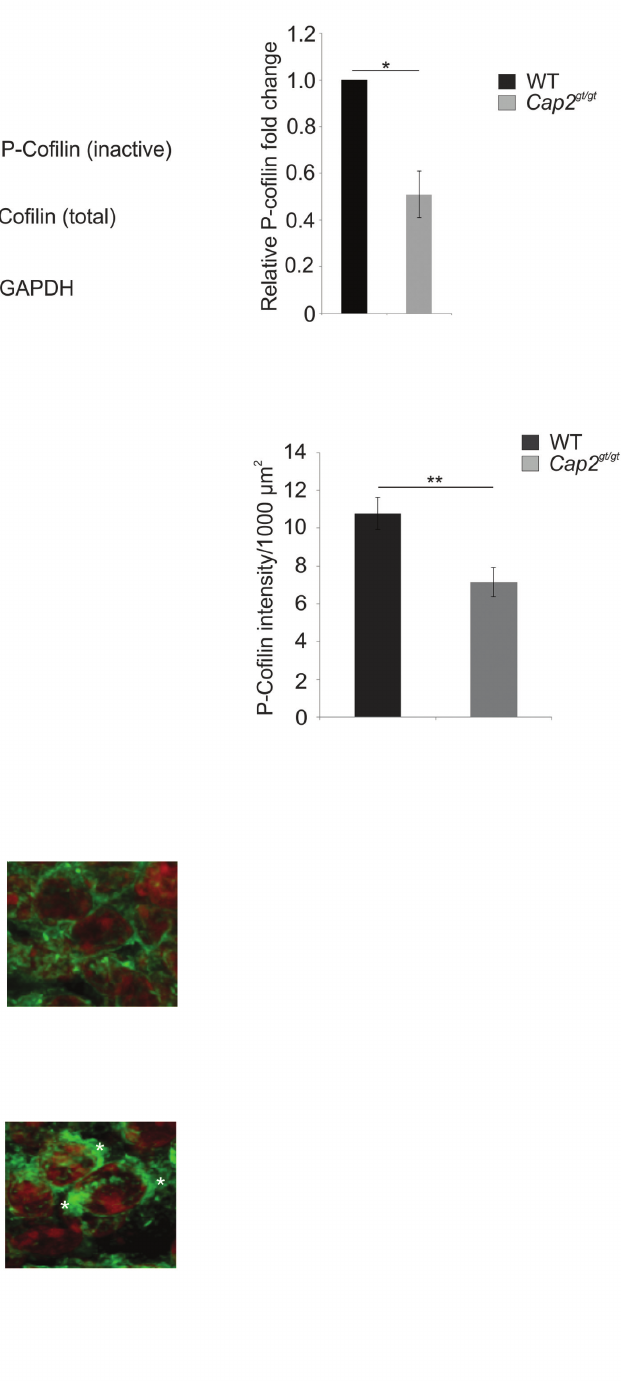
Frontiers in Cellular Neuroscience |